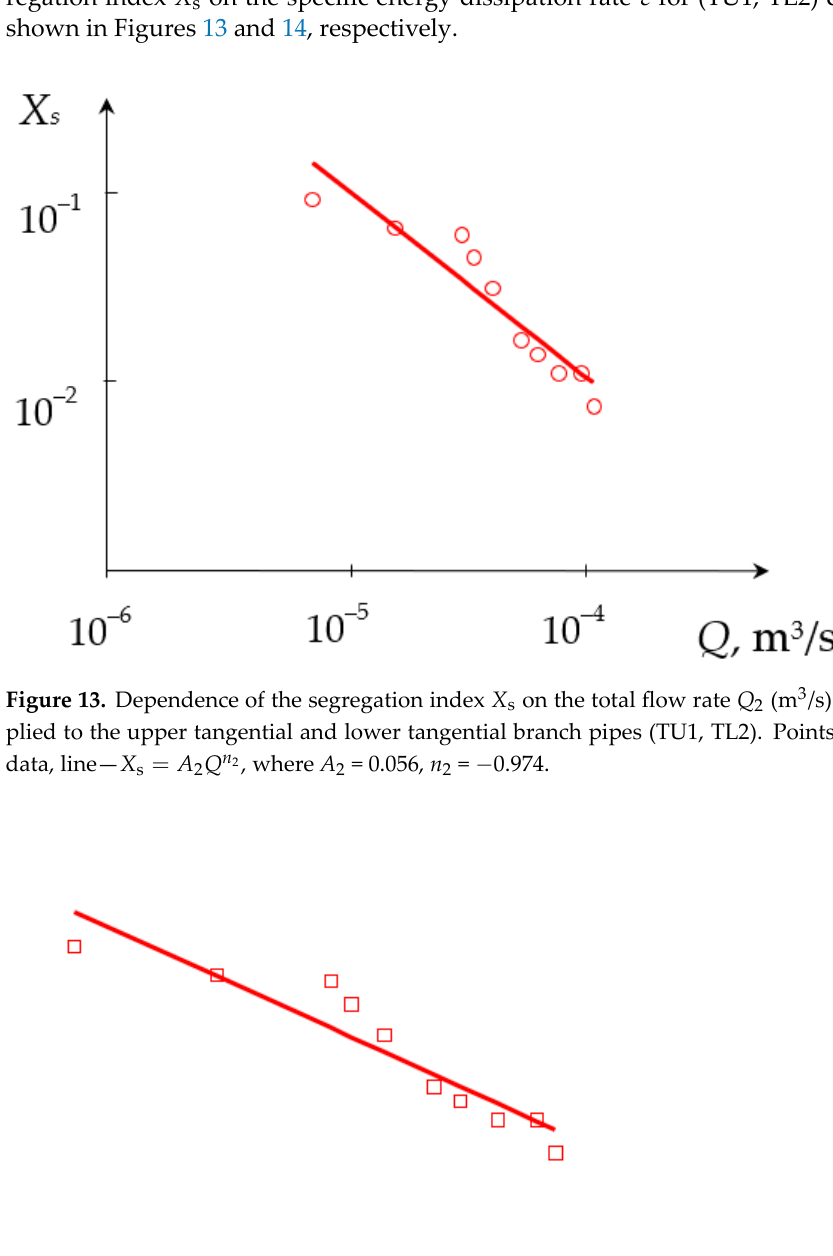
Figure 12. Dependence of the segregation index X s on the specific energy dissipation rate ε (kW/kg) for liquids supplied to two upper tangential branch pipes (TU1, TU2). Points—experimental data, line—result of smoothing.